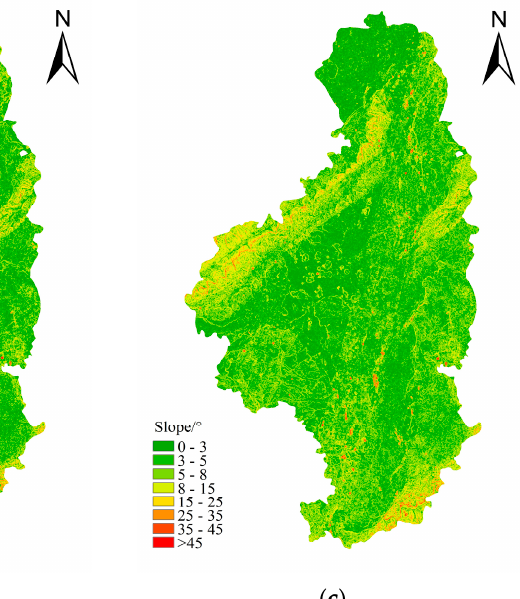
Table 5. Topographic feature parameters of the three DEM data.